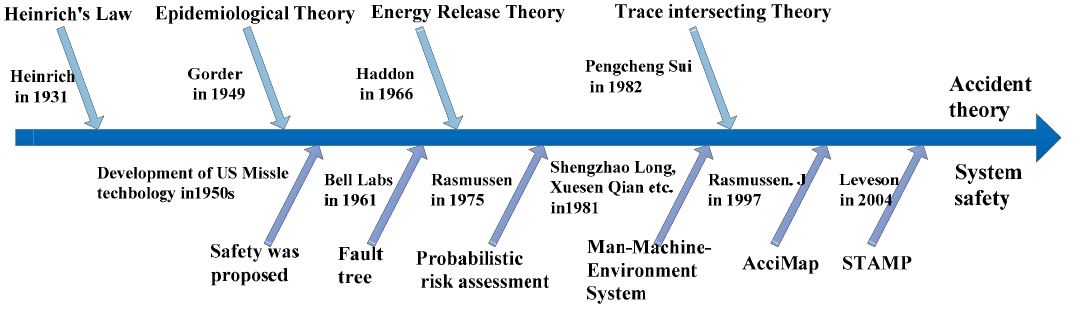
Figure 2. Development of safety theory.